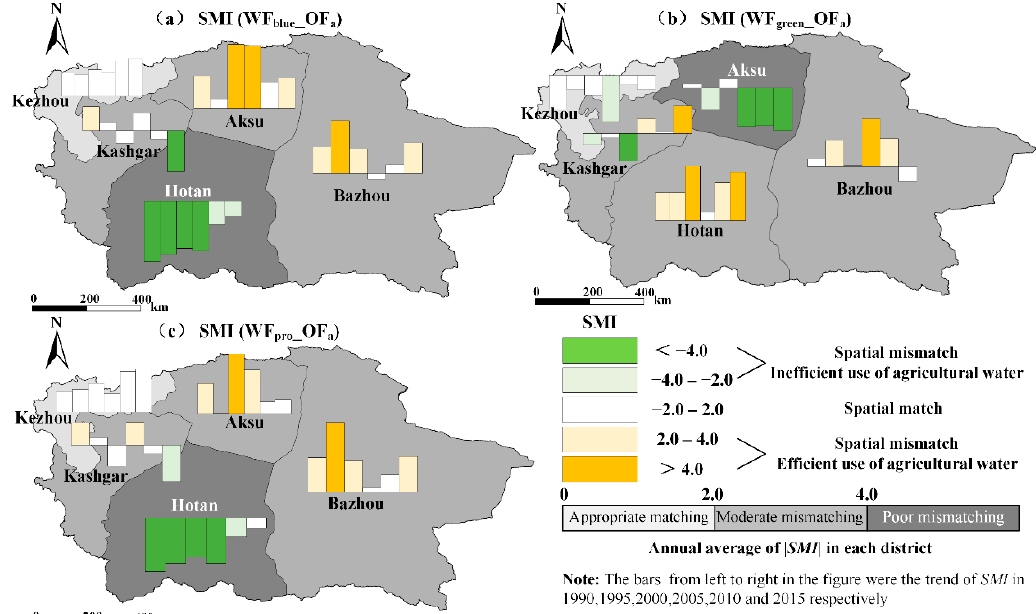
Figure 5. The spatial-temporal pattern of spatial mismatch index from 1990 to 2015. ( a ) The spatial mismatch index between blue water footprint and oasis farmland area ( SMI (WF blue _OF a ) ); ( b ) The spatial mismatch index between green water footprint and oasis farmland area ( SMI (WF green _OF a ) ); ( c ) The spatial mismatch index between crop production water footprint and oasis farmland area ( SMI (WF pro _OF a ) ).